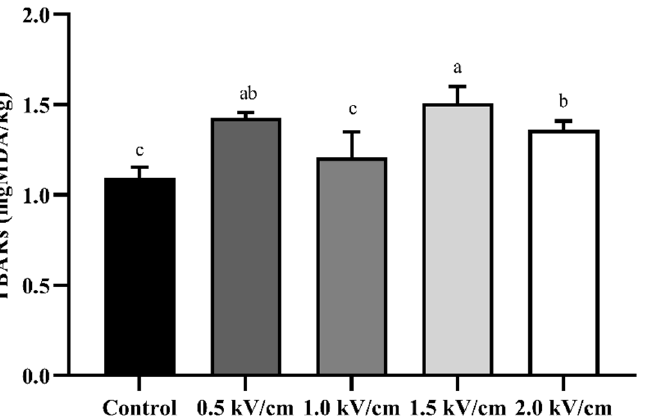
Figure 5. Lipid oxidation using TBARs for beef processed with PEF at different field strengths. Error bars indicate the standard deviation of six replications (n = 6). Different letters indicate a significant difference ( p < 0.05) .